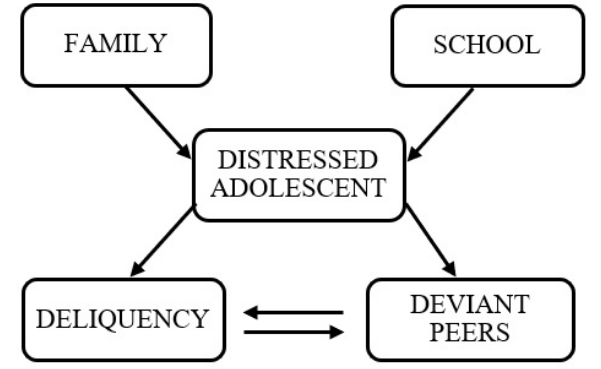
Figure 2. Five major factors leading to institutionalization.